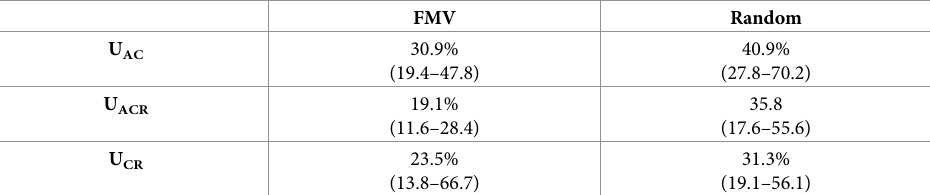
Table 4. Intra-individual coefficients of variation of albuminuria in adults (Witte et al. JASN 2009) based on three urine